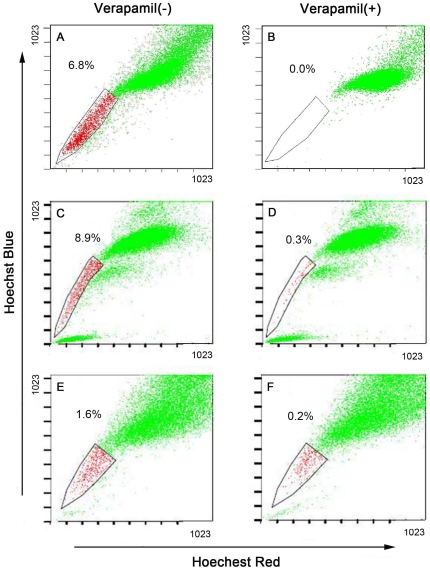
SP re-analysis in various samples.A–B, SP re-analysis when the SP spheres were disaggregated and dissociated cells cultured in normal serum-containing medium for one week. C–D, SP re-analysis in the SP cell-derived tumors. E–F, SP re-analysis in non-SP cell-derived tumors. A, C, E, without verapamil. B, D, F, with verapamil.